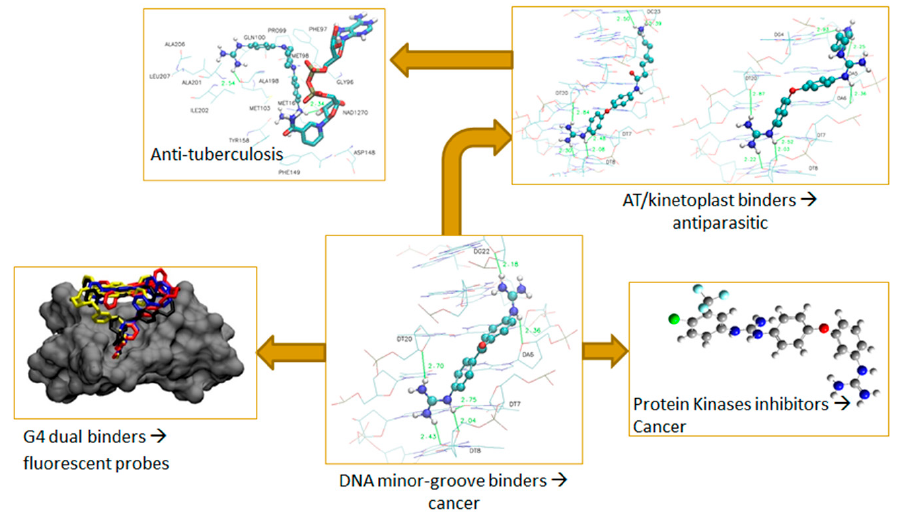
Figure 4. DNA minor-groove binders for different applications.